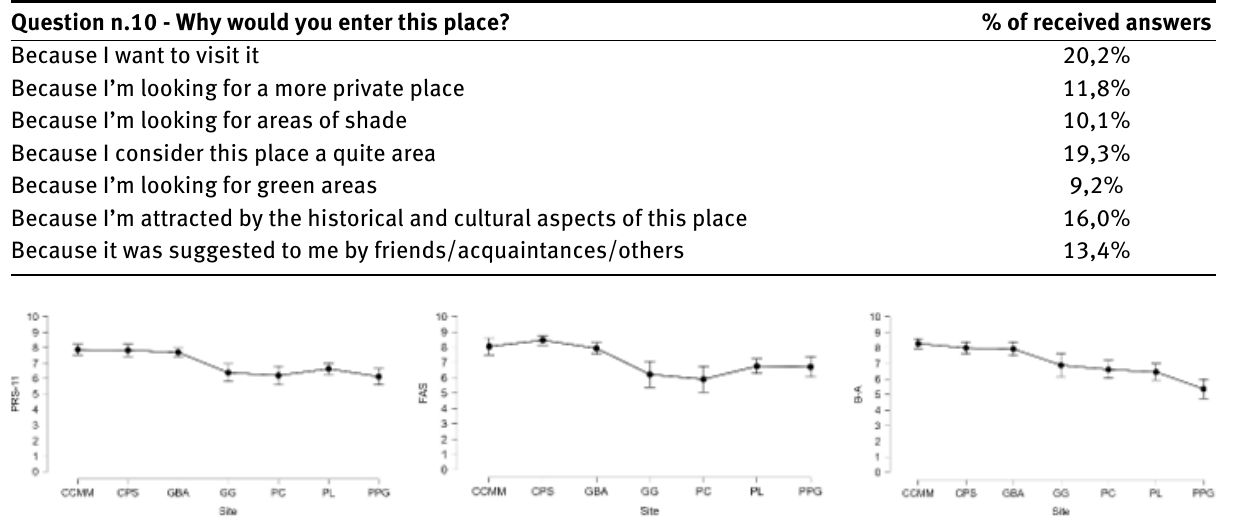
Figure 4: Marginal means of the scores of sites. PRS-11 (left), Fascination (middle) and Being-away (right) Whiskers indicate the standard error